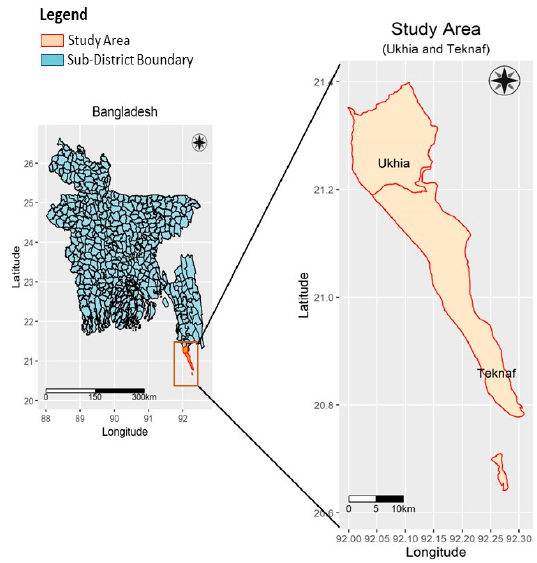
Figure 1. Geographical location of the study area.